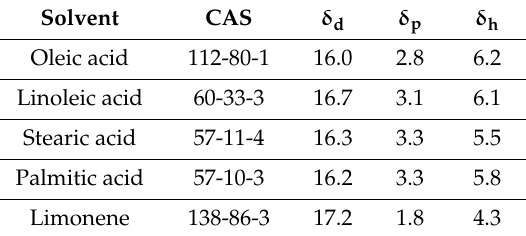
Table 2. Hansen solubility parameters of each solvent.